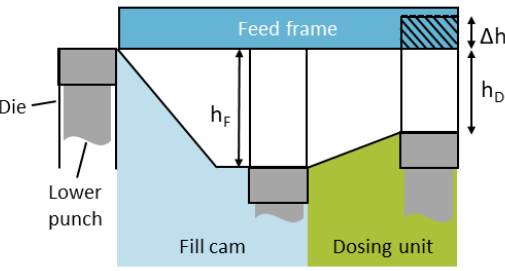
Figure 1. Schematic overview of the punch positions used for filling with perspective from the side – fill depth h F , overfill ∆ h and the resulting dosing depth h D .